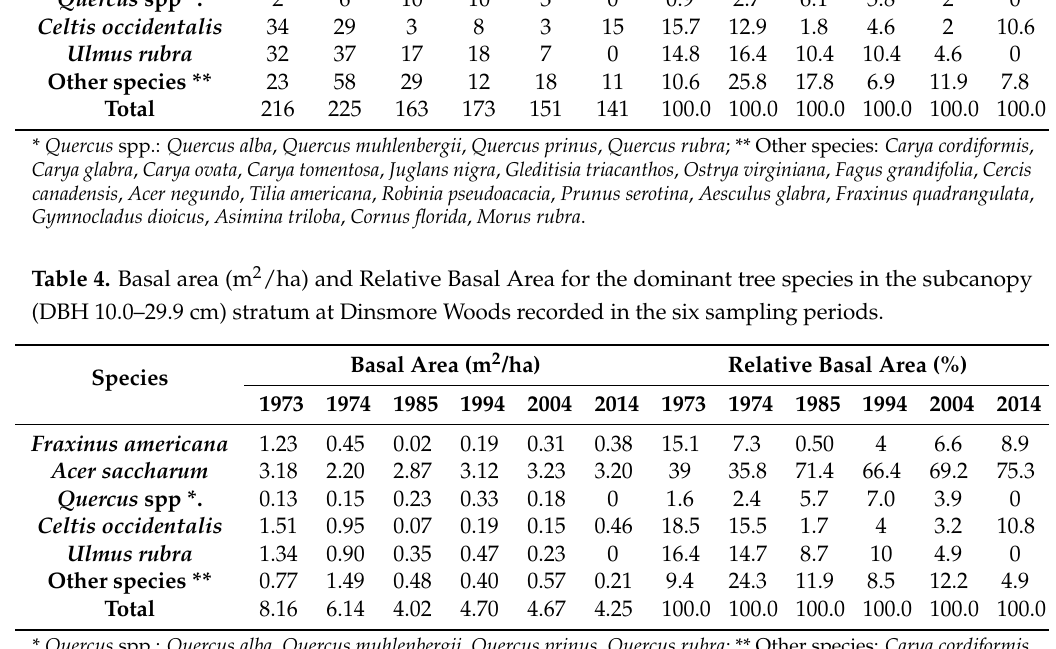
recorded in the canopy stratum (DBH ≥ 30.0 cm) at Dinsmore Woods in the six sampling times.